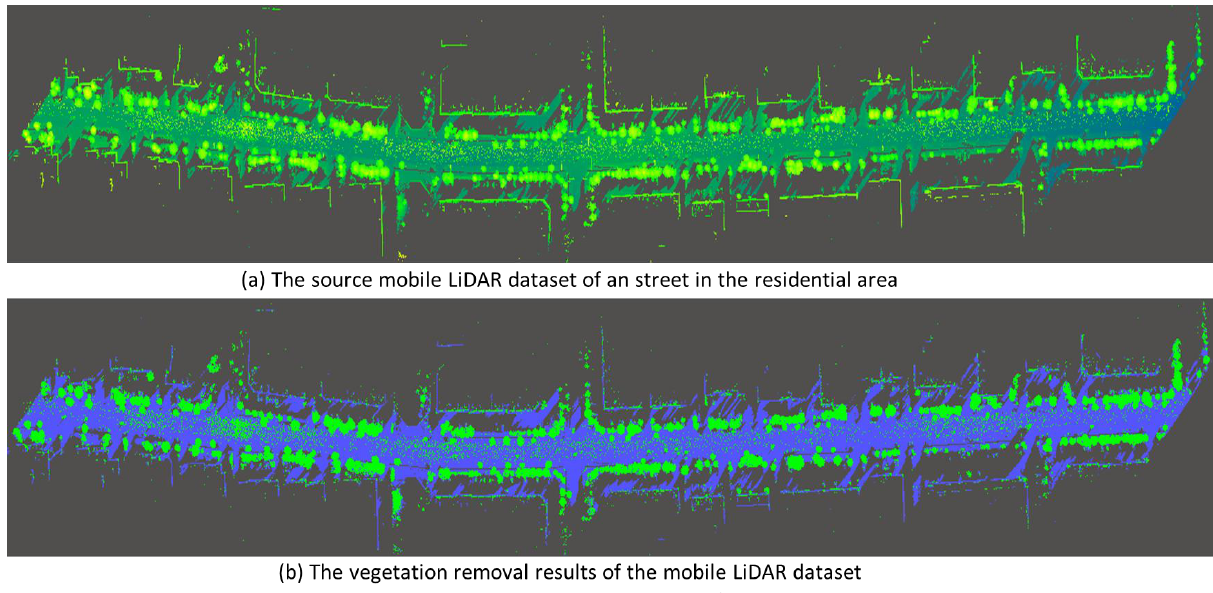
Figure 10. The overall vegetation removal results of the mobile LiDAR